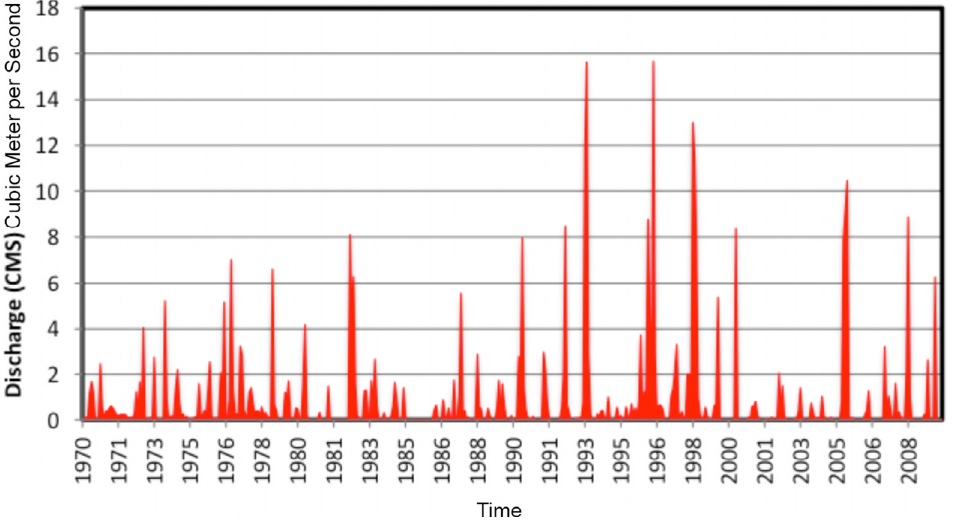
Figure 6. Time series of discharge at Garaik hydrometric station.